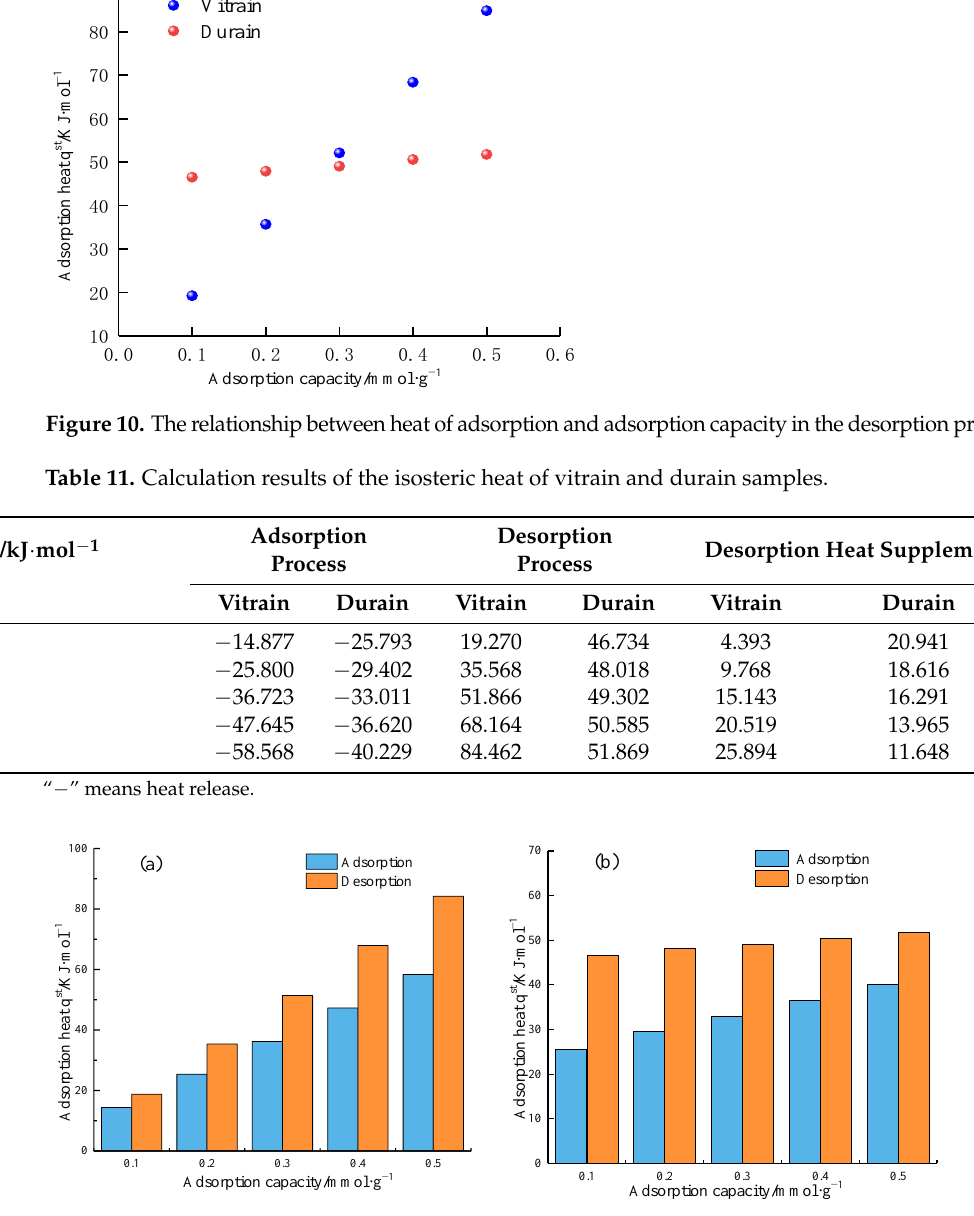
Figure 11. Comparison of adsorption heat during the adsorption and desorption process: ( a ) vitrain; ( b ) durain.